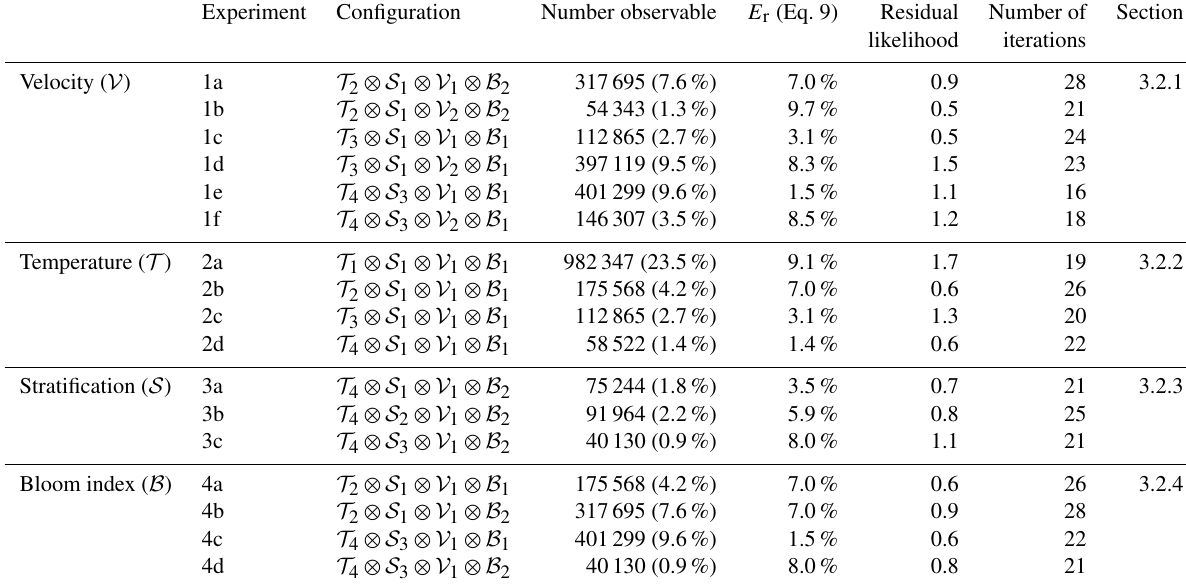
Table 3. Experiment table. List of conducted experiments, their corresponding configurations and the evaluation diagnostics: mean relative error on the coefficients, residual likelihood and number of iterations. The tested regime (primary variable) is specified in the first column, the number of observable belonging to each configuration is indicated in the fourth column, with their relative proportion in brackets. Note that, even if the number of observable points differs for each configuration, the experiments were conducted with 400 observations randomly chosen among the ones belonging to the configuration. The section that describes each experiment is mentioned in the last